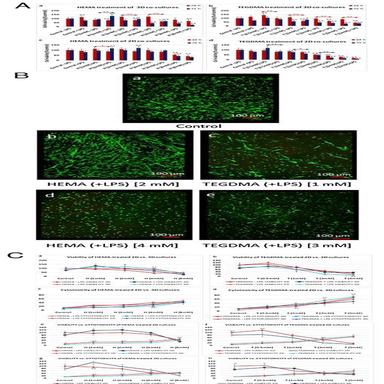
A: Cytotoxic effects of LPS and/or resinous monomers, HEMA (a) or TEGDMA (b) on the HUVEC/SCAP co-cultures of the lower compartment of DentCytoTool, as compared to 2D HUVEC/SCAP control co-cultures exposed to the same concentrations of HEMA (c) and TEGDMA (d), evaluated by MTT assay. Black asterisks indicate statistically significant differences compared to the respective control (- LPS) cultures (\p < 0.05, \\p < 0.01). Blue